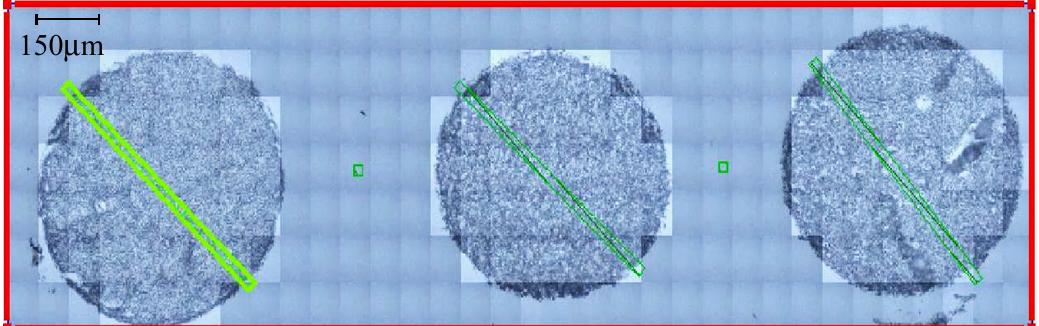
Figure 2. Microscope image taken of three brain tumour tissue microarray cores prior to infrared interrogation. Green squares (10 × 10 µm) represent the points where spectra were collected.